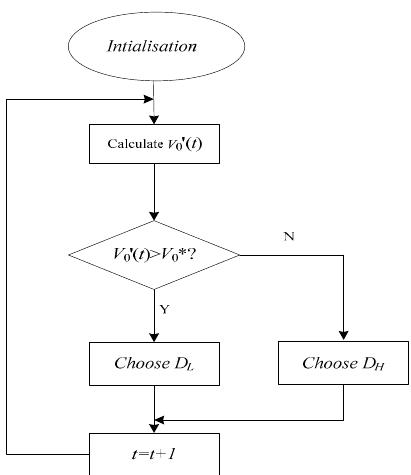
Figure 11. Flowchart of the STM 32 controller.